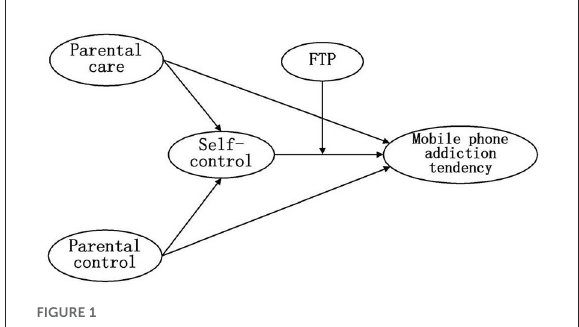
FIGURE1 Proposed moderated mediation analysis of self-control on the relationship between parental control and parental care and adolescents’ mobile phone addiction tendencies conditioned by future time perspective